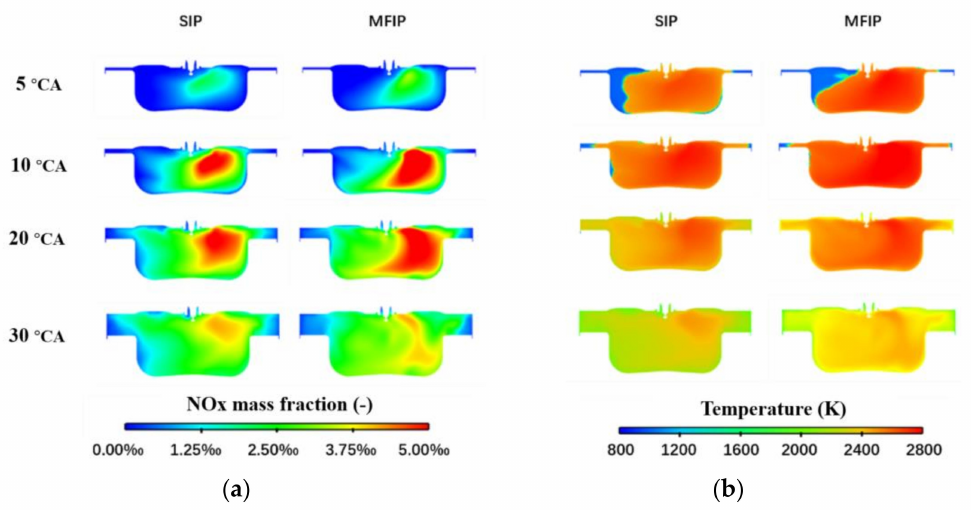
Figure 8. Comparison of SIP and MFIP in ( a ) NO x mass fraction and ( b )